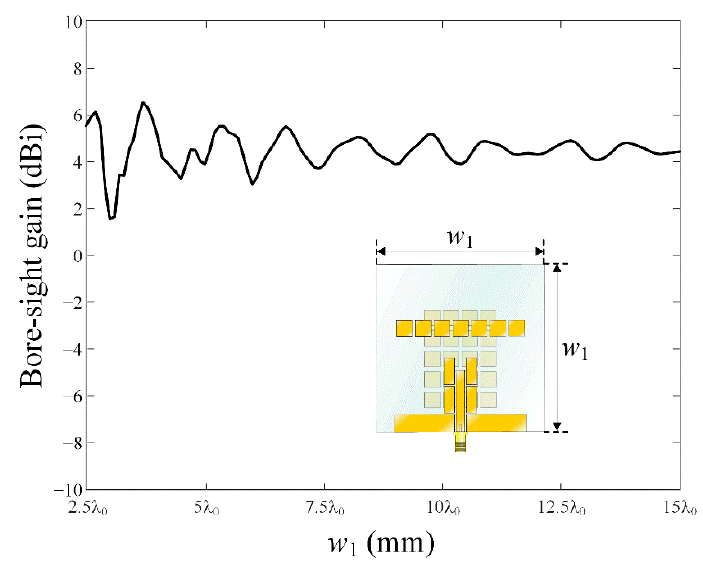
Figure 10. Bore-sight gain in accordance with the parameter w 1 .